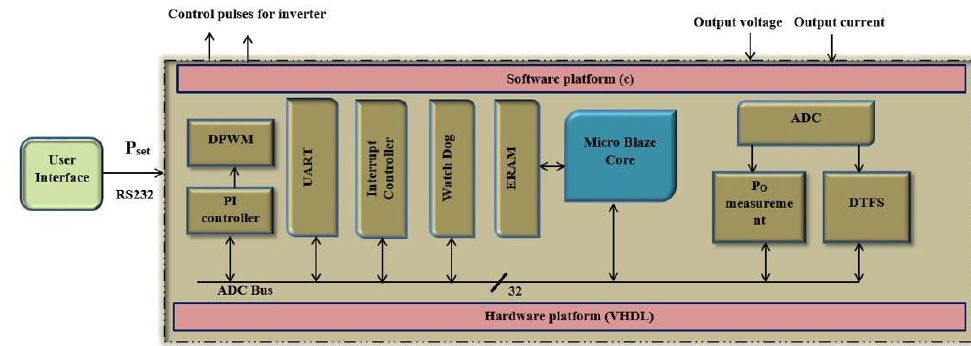
Figure 22. FPGA-based power control architecture proposed in [99].